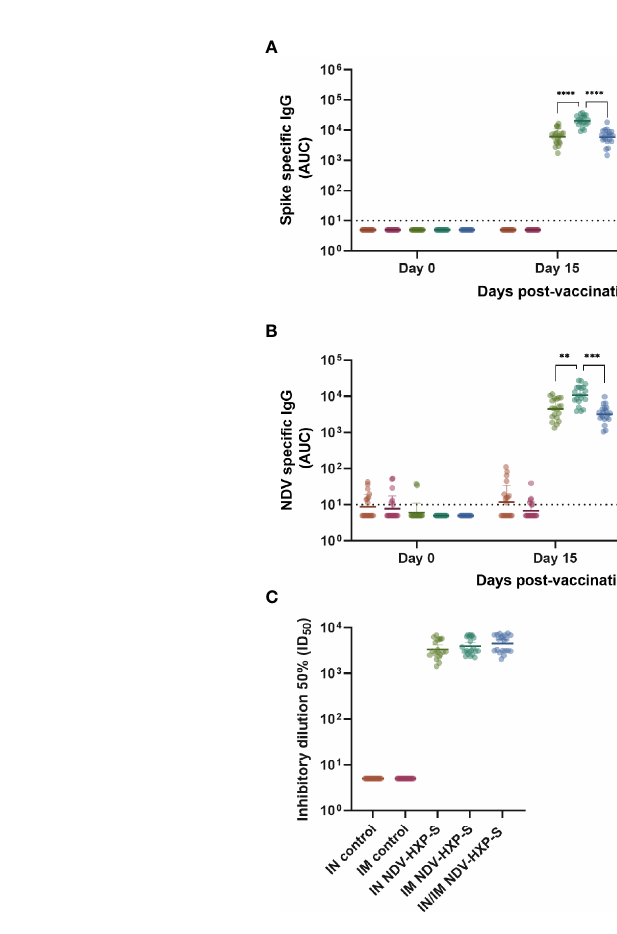
FIGURE 4 | Immunogenicity of NDV-HXP-S after intranasal and intramuscular administration to rats. IgG antibody levels against wild type spike from SARS-CoV-2 (A) and NDV virus preps (B) were measured by ELISA in sera from vaccinated rats at days 0, 15 and 30 after the fi rst vaccine dose administration. In both cases, antibody levels are expressed as area under the curve (AUC). The neutralization capacity of serum antibodies against the authentic USA-WA1/2020 SARS-CoV-2 isolate at day 30 after the fi rst vaccine dose administration is shown in (C) , and titers are expressed as inhibitory dilution 50% (ID 50 , right panel). As a control, the inhibitory concentration 50% (IC 50 - m M) of the virus polymerase inhibitor remdesivir is shown (right panel). Geometric mean with geometric standard deviation (SD) for the IN control, IM control, IN vaccinated, IM vaccinated, and IN-IM vaccinated groups is shown in all panels. In (A – C) , all vaccinated groups showed statistically signi fi cant differences vs their respective controls. The IN-IM administered group was compared with the IM control group. Statistically signi fi cant differences between the IN, IM and IN-IM groups are shown. Statistical signi fi cance is indicated as follows: *P ≤ 0.0270; **P ≤ 0.0032; ***P ≤ 0.002; ****P <